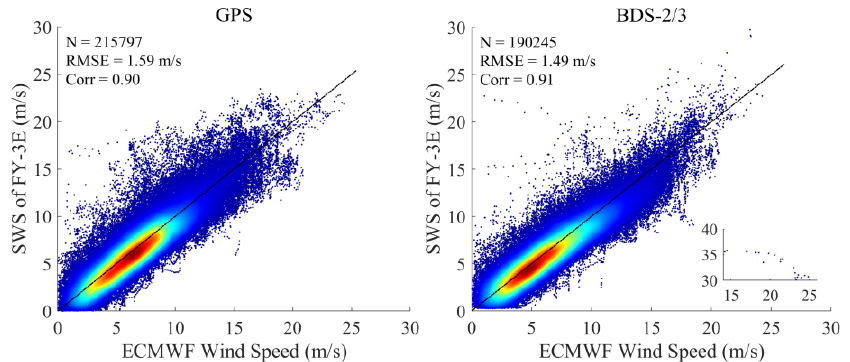
Figure 12. The comparison between SWS products of the GNOS-II onboard the FY-3E satellite, and ECMWF wind speeds, corresponding to GPS (left) and BDS-2/3 (right), respectively. The N represents the number of SWS products; RMSE represents the means root mean square error between the SWS and the corresponding ECMWF wind speed; Corr denotes the correlation coefficient between the SWS and the corresponding ECMWF wind speed. The sub-coordinate in the right bottom corner of the right figure, shows the part where the SWS is over 30 m/s.